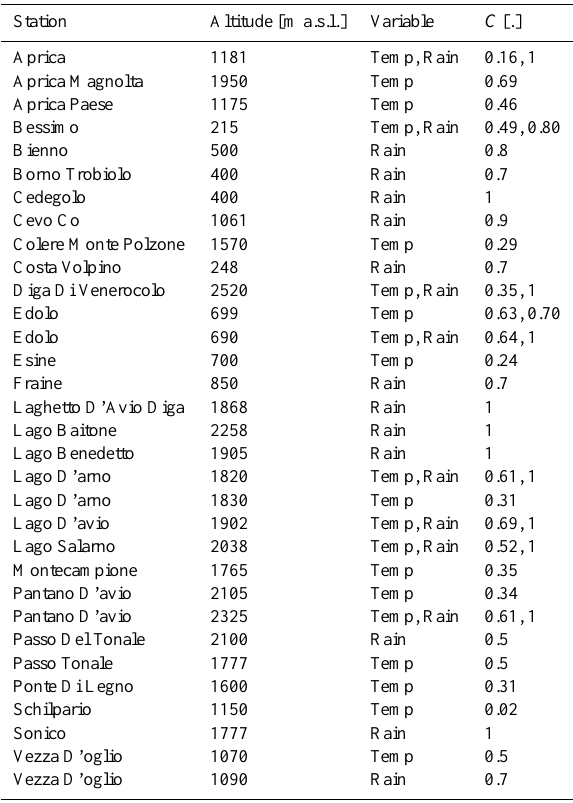
Table 1. Measuring stations and measured variables during 1990– 1999. C is completeness index (i.e. number of available daily mea- surements out of the total number of days in the measuring